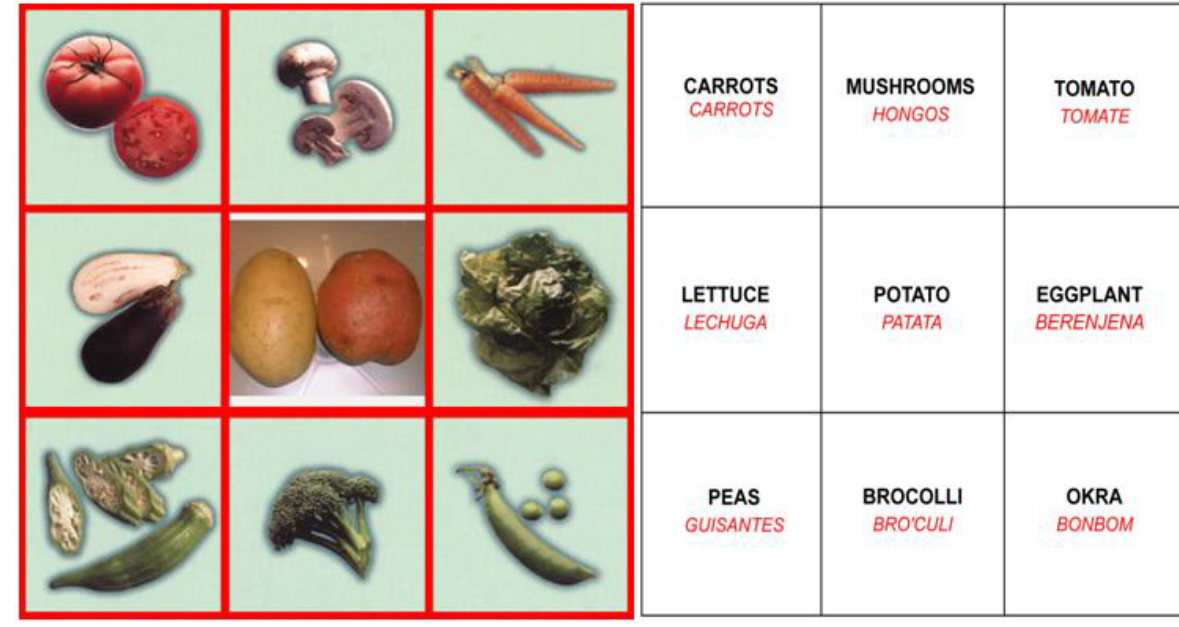
Figure 1. Game board: Front (pictures), Back